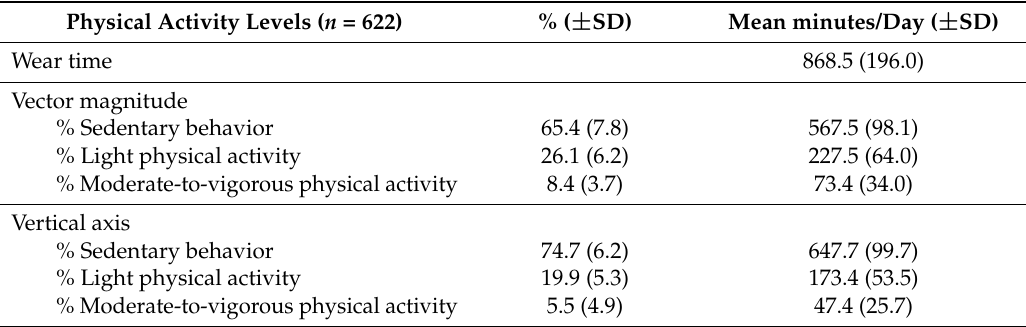
Table 2. Participants’ physical activity levels based on vector magntiude (VM) and vertical axis (VT) calculations.